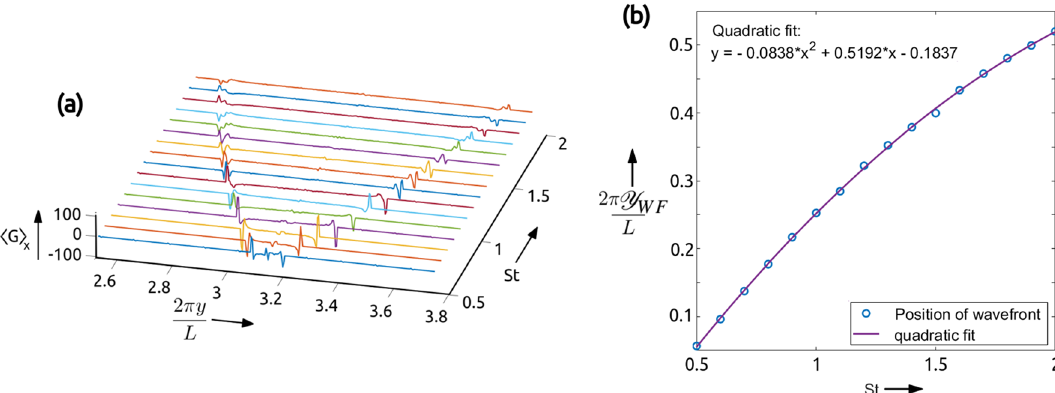
Figure 4. In (a) we show the plots of (cid:31) G (cid:30) x obtained for different values of the Stokes number from mono- disperse systems. We extract the location of the peaks in (cid:31) G (cid:30) x for each St , as defined in Eq. (7), to generate the plot in (b) and we find that the Y WF and St have a quadratic dependence. The plots were generated using Matlab 2020a, https:// www. mathw orks. com/ produ cts/ matlab. caustic structures. Furthermore, we find that the intensity of each wavefront compared to the background, which we refer to as prominence 35 , depends on the corresponding initial particle concentrations in the system. We now prescribe a method to extract the position of the wavefront from DMD. We use a Sobel operator 36